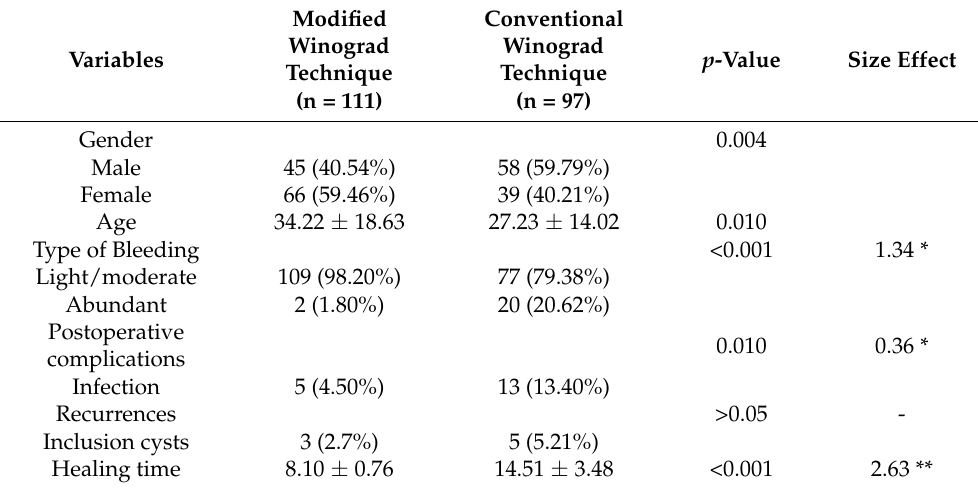
Table 1. Outcome of treatment with modified and conventional Winograd techniques comparison.